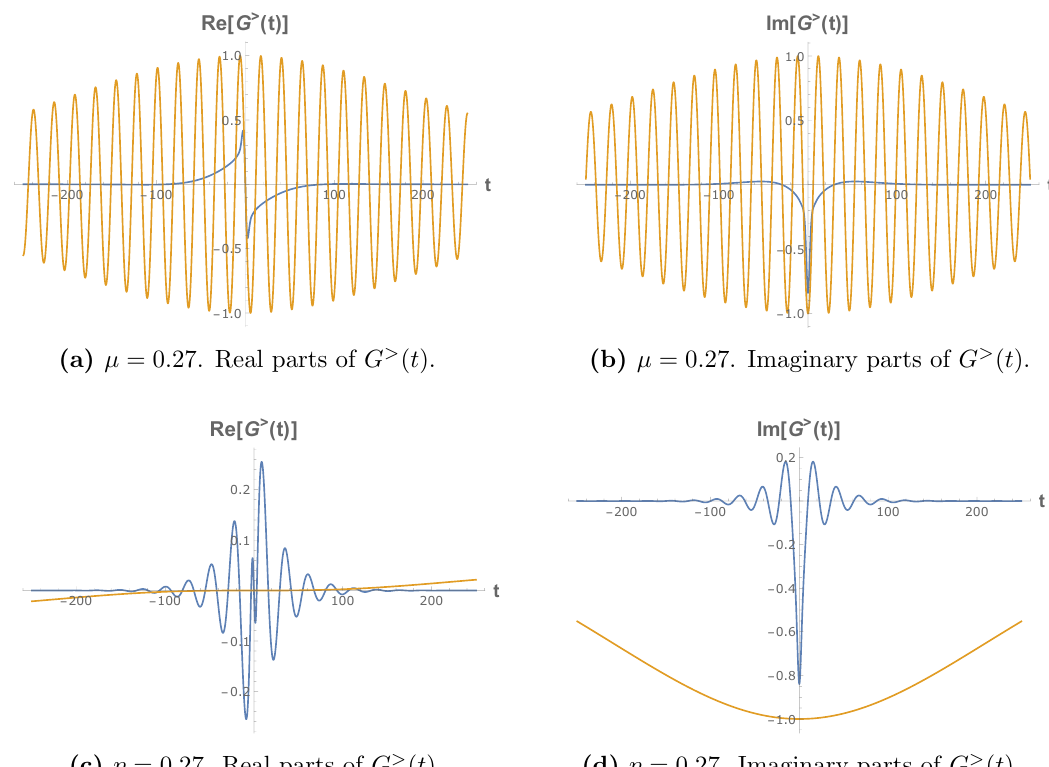
Figure 4. Greater Green’s functions G > ( t = t 1 (cid:0) t 2 ) for (cid:12) = 40 in the two di(cid:11)erent phases. The blue curves are the values in the chaotic state while the orange curves are the values in the integrable phase. (a) is the real parts with (cid:22) = 0 : 27, (b) is the imaginary parts with (cid:22) = 0 : 27, (c) is the real parts with (cid:17) = 0 : 27 and (d) is the imaginary parts with (cid:17) = 0 : 27. Note that the plots of G > ( t ) in the integrable phase are for illustrative purpose. They have signi(cid:12)cant (cid:12)nite- t e(cid:11)ect.